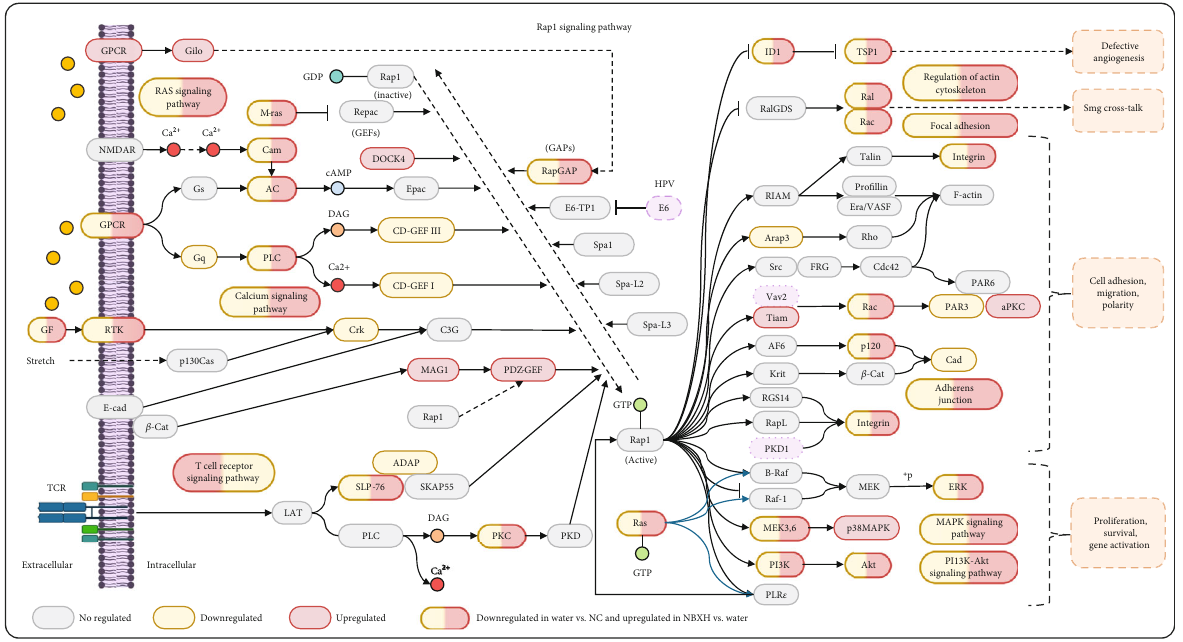
Figure 8: Pathway map explanation of the RAP1 signal pathway. Light yellow marked nodes are associated with downregulated genes; light red marked nodes are associated with upregulated genes; light gray nodes have no signi fi cance. The nodes that are light yellow on the left and light red on the right indicate genes or pathways that are downregulated in M. tuberculosis -infected mice (Water vs. NC) but upregulated after NBXH-H treatment (NBXH-H vs. Water). The nodes that are light red on the left and light yellow on the right indicate genes or pathways that are upregulated in M. tuberculosis -infected mice (Water vs. NC) but downregulated after NBXH-H treatment (NBXH-H vs. Water). ∗ Endocrine and other examples of factor-regulated calcium